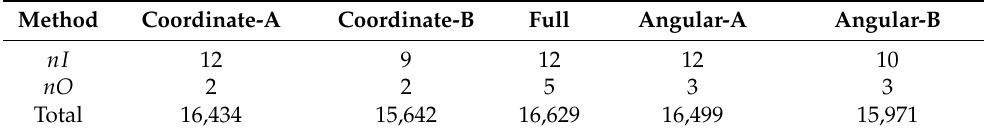
Table 11. Number of RNN parameters according to five combinations of variable sets.